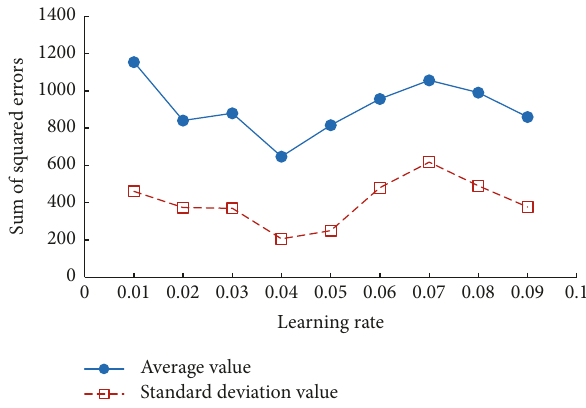
Figure 5: Relationship between learning rate and sum of squared